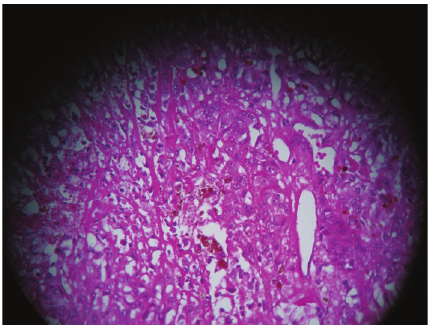
Figure 1: Section of tumor mass shows pigmented malignant melanocytes (HES × 20).